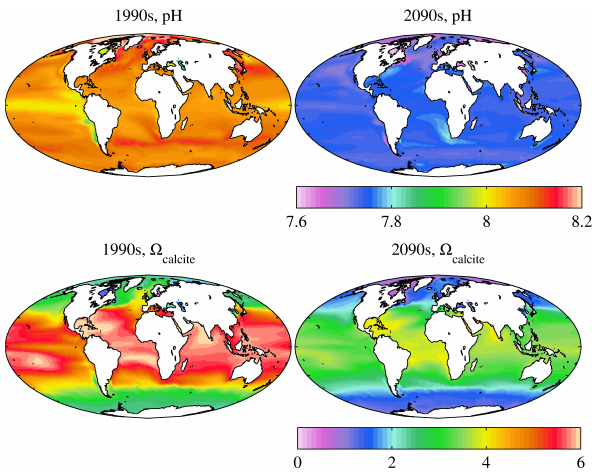
Fig.15. Annualaverage1990s( left )and2090s( right )surfacepH( top ;–)andsurface Ω calcite ( bottom ;–). Fig. 17. Annual average 1990s (left) and 2090s (right) surface pH (top; –) and surface (cid:127) calcite (bottom; –).